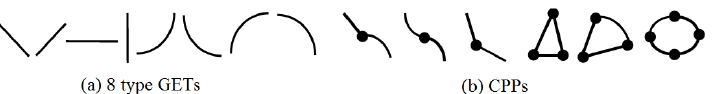
Figure 2. Handcrafted discriminative shape features. ( a ) lists 8 types of Generic Edge Tokens (GETs), along the edge curves; GETs are monotonic shape entities connected at Curve Partitioning Points (CPPs) listed in ( b ). GETs and CPPs are perceptual shape features that are extracted from edge contours and provide a set of basic shape descriptors for the semantic vocabulary.